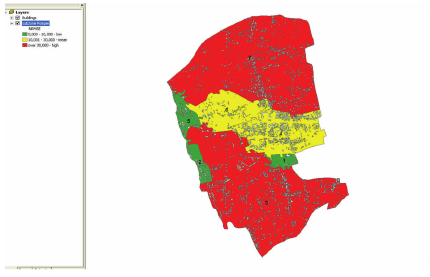
Figure 4: Thematic map of NRMSE.